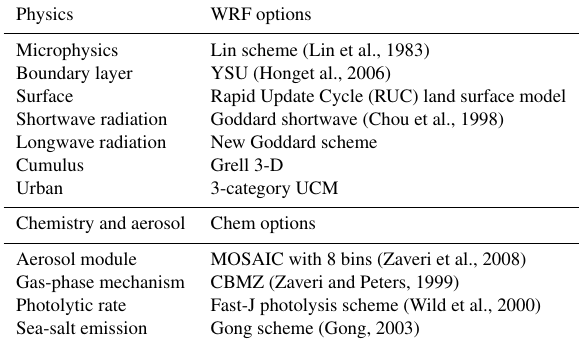
Table 1. Configurations of